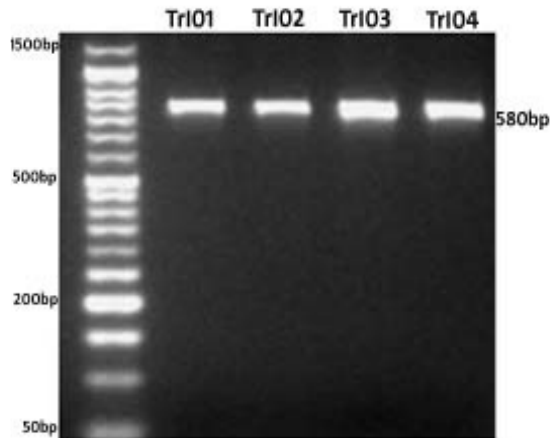
Figure 6: Gel-electrophoresis image obtained with four different samples, represent four different regions in Trincomalee district. Lane 1 = DNA marker. Lane 2-5 = PCR products obtained by the amplification of ITS region of the four isolates. The PCR product size is about 850 bp.